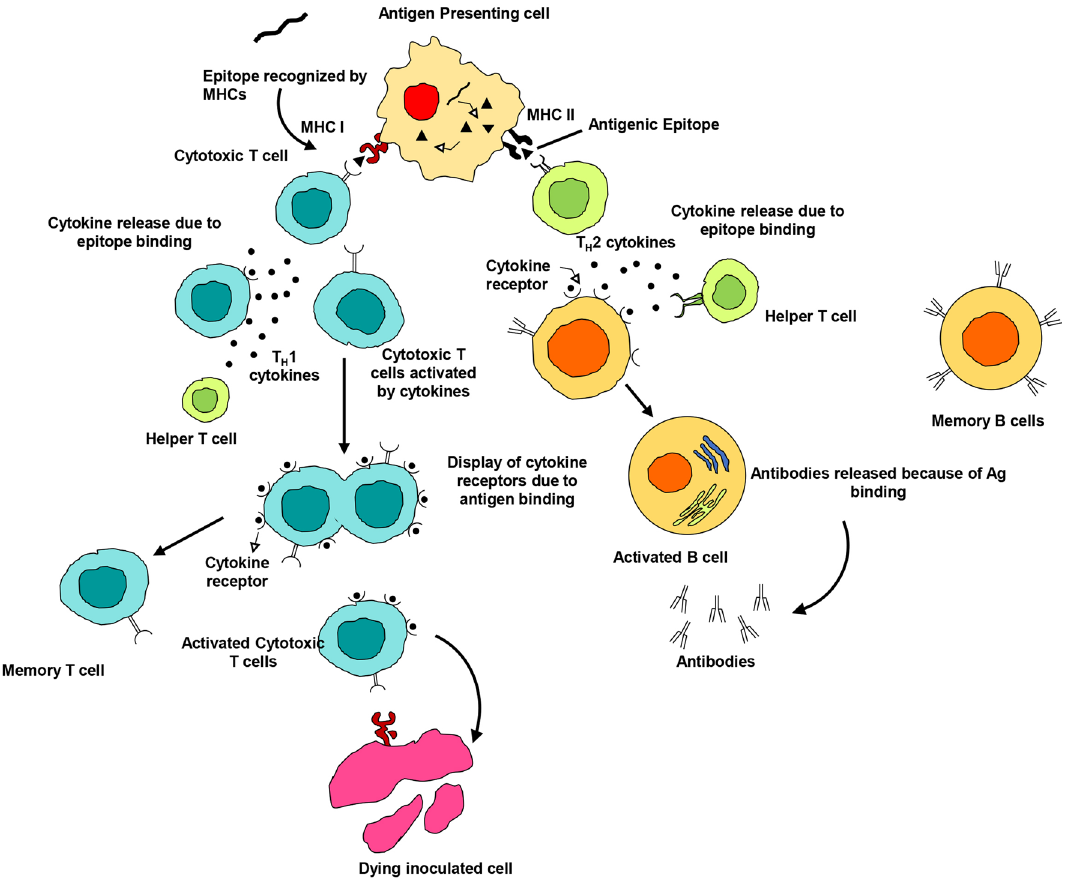
Figure 1. Immune mechanism of action elicited by the vaccine